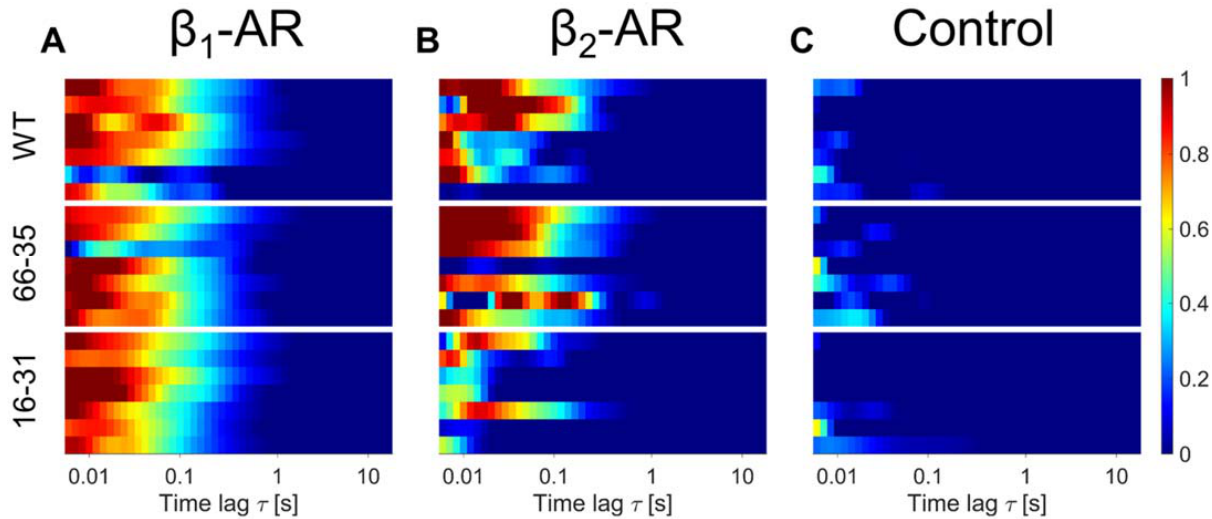
Figure 4. Comparison of β 1 ‐ AR ( A ) and β 2 ‐ AR ( B ) membrane expression in hiPSC ‐ CMs at day 60 of maturation. ( C ) Shows the acquired linescan ‐ FCS data of hiPSC ‐ CMs at day 60 of maturation pre ‐ treated with 100 μ M propranolol (Control). Each subpanel represents wildtype (WT) hiPSC ‐ CMs ( top ), clone 66–35 ( middle ) and clone 16–31 ( bottom ). Colorscale indicates the amplitude of normalized autocorrelation curves. Normalized was to each G(0) or highest peak of the curve (See Section 4). Each bar represents the scan at the surface of one cell. For each cell line and condition scans of seven different hiPSC ‐ CMs are evaluated. Both receptor subtypes show a diffusional fingerprint at the surface plasma membrane of the WT cells and clones at day 60. Control cells indicate no detected diffusing receptors (blue).